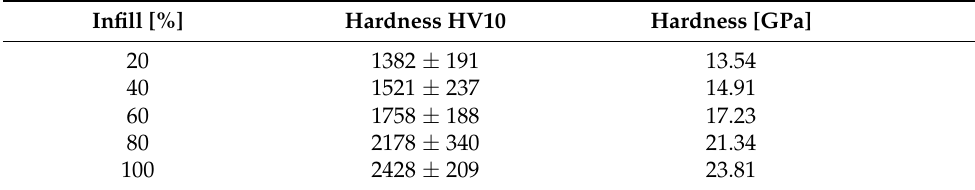
Table 3. Hardness of alumina depending on the infill percentage. Infill [%]